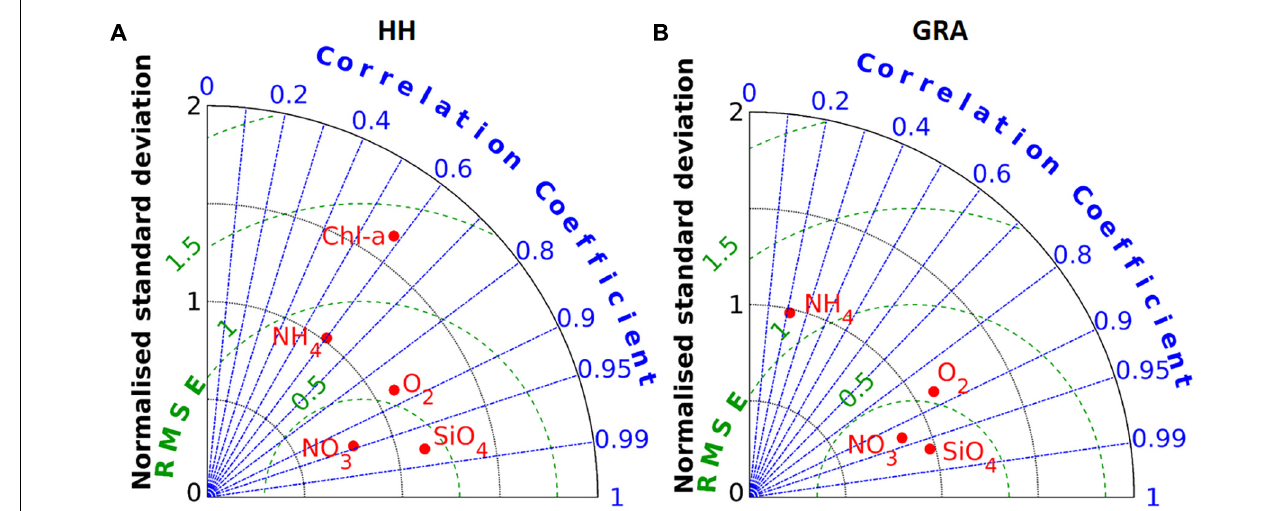
FIGURE 7 | (A,B) Taylor diagrams illustrate the model performance regarding nutrients and oxygen at the stations of Seemannshöft (HH) and Grauerort (GRA). Chlorophyll measurements were available only for Seemanshöft and are represented in (A) .